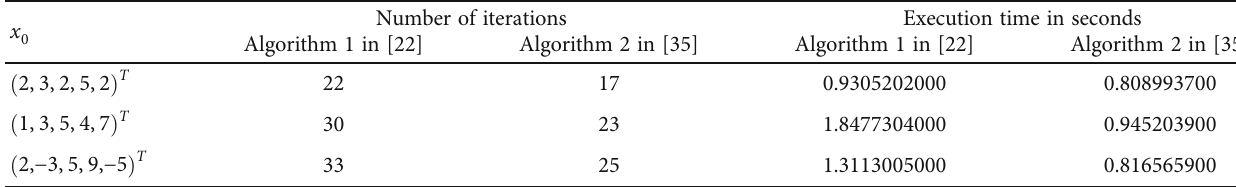
Figure 14: All methods are compared computationally while x Table 3: All methods ’ numerical values for Figures 9 – 14.